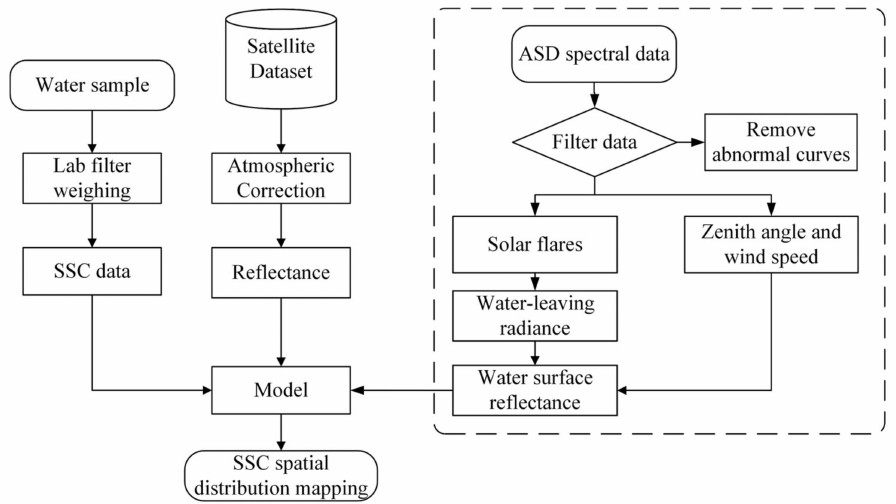
Figure 5. Image retrieval workflow with integrated satellite images and field